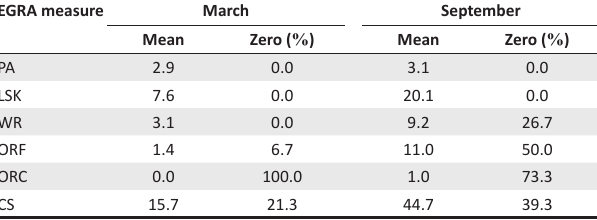
TABLE 8: Descriptive statistics for T5 classroom in school E. EGRA